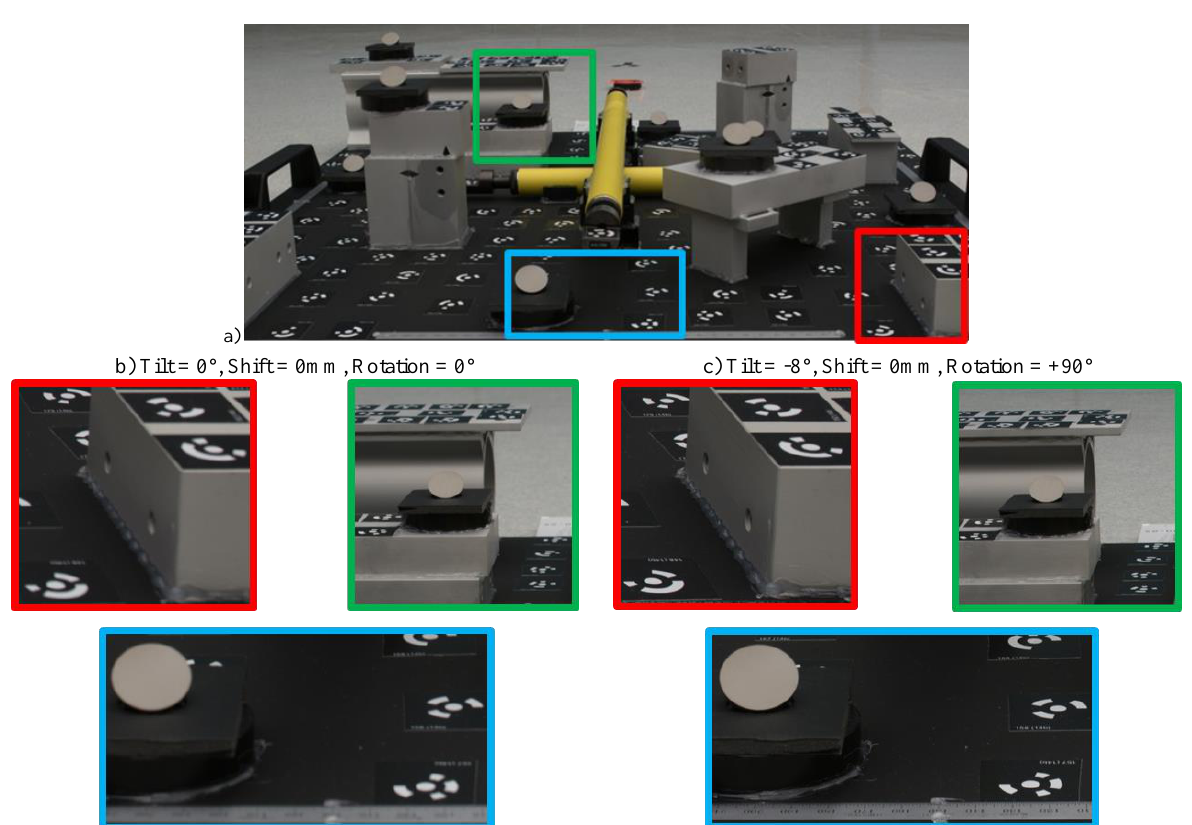
Figure 4 – Example of DOF improvement with the use of tilt-shift lens: a) reference image with a full frame DSLR camera and a 45mm lens @ f/11. The length of the object is 700 mm and the focus distance is set to 1000 mm; b) details of the reference image acquired with the optical axis perpendicular to the image plane (normal condition); c) details of the reference image acquired with a non-zero tilt angle.